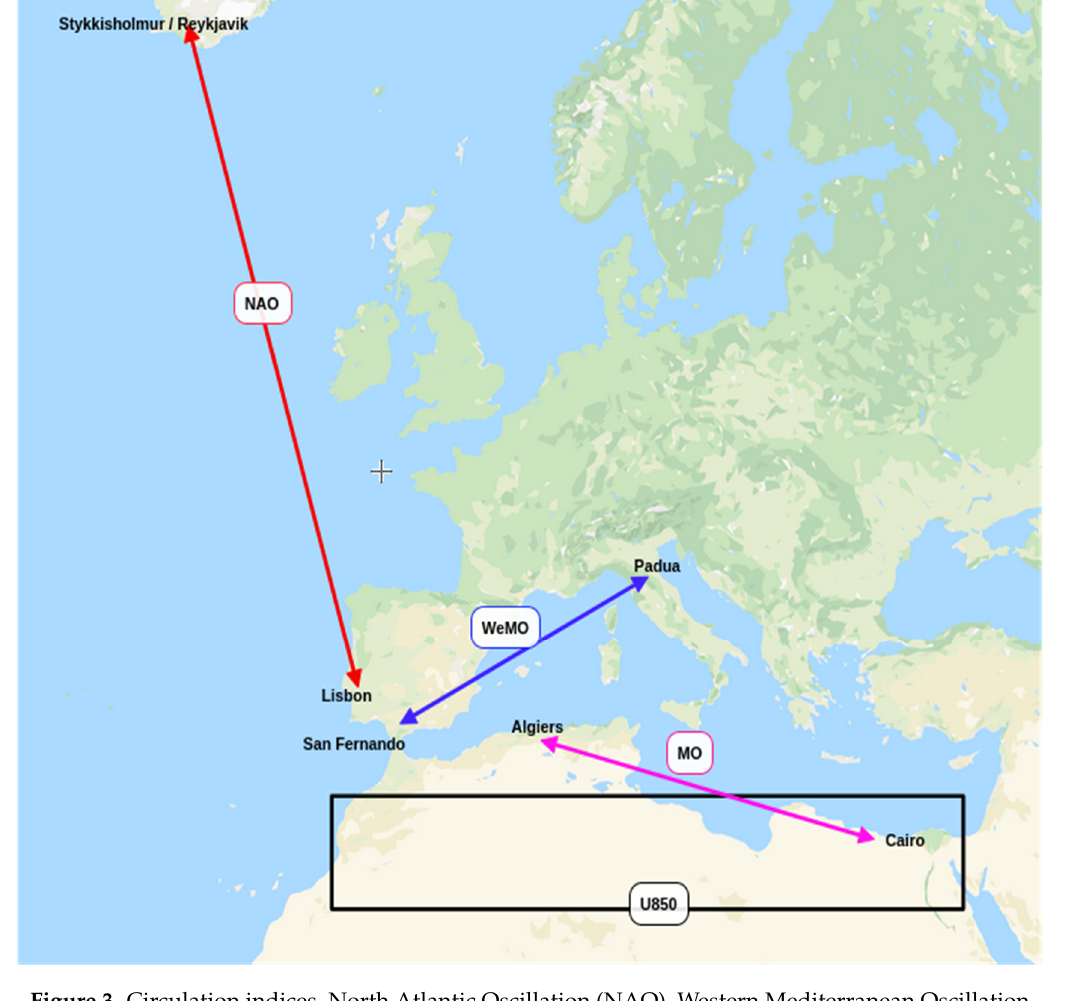
Figure 3. Circulation indices, North Atlantic Oscillation (NAO), Western Mediterranean Oscillation (WeMO), and Mediterranean Oscillation (MO), and zonal wind speed at 850 hPa (U850, averaged over black box as in [19]) (map source: https://www.scribblemaps.com).